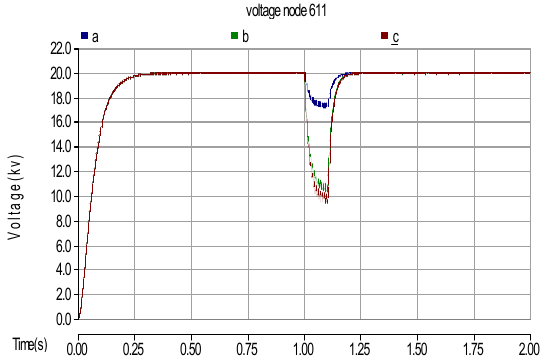
Figure 5. Voltage variations in bus 611 due to types of unsymmetrical short circuit faults in bus 671 and in uncompensated system: ( a ) single-phase to ground fault; ( b ) two-phase fault; ( c ) two-phase to ground fault.